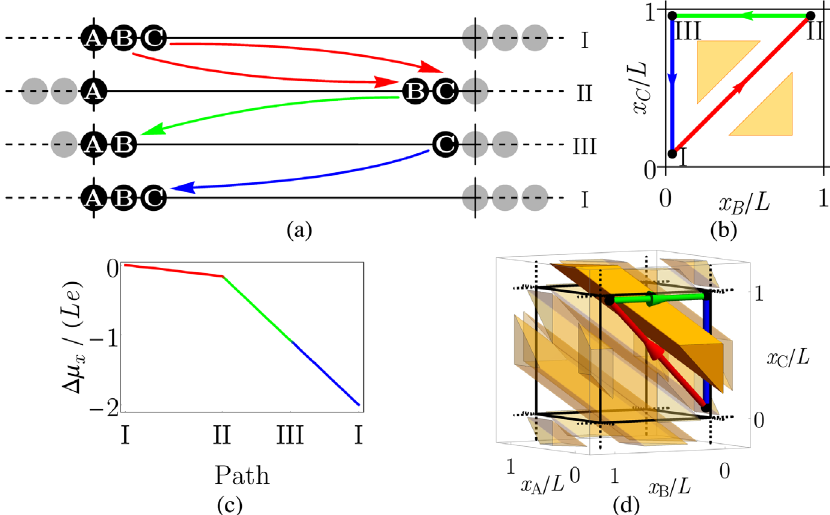
FIG. 2. Linear H þ 3 in periodic boundary conditions. (a) I: Equilibrium configuration: The black circles and continuous line indicate atoms in the primitive supercell; gray circles and the dashed line indicate their periodic images. II and III are the two intermediate steps of the closed path described in the text. (b) Closed path in the 2D projection of the atomic configuration space relative to the atoms that participate in the loop; the yellowish areas indicate regions where the ground state is degenerate. (c) Dipole displaced along the closed path. Notice that the total displaced dipole is finite and an integer multiple of eL . (d) Closed path in the 3D projection of the ACS where also the x coordinate of atom A is shown. The metallic region encircled by the path extends for all values of x A , and the loop cannot be shrunk to a point without crossing it: The loop is, thus, nontrivial. 3D projections onto subspaces where x A is substituted with any other atomic coordinate have a similar appearance. An animation illustrating the trajectory of the atoms participating in the loop can be found in the file S1.mp4 in Supplemental Material [18]. In the animation, the green dot indicates the position of the Wannier center of the two electrons in the